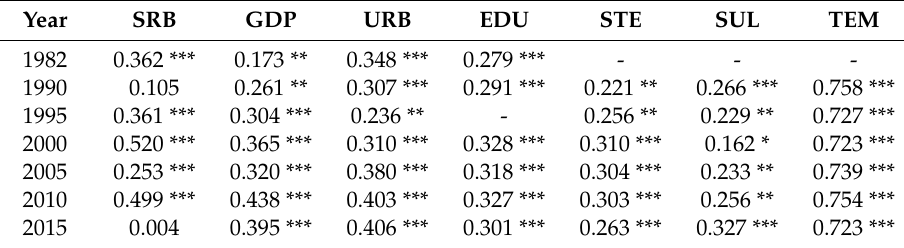
Table 2. Global Moran’s Index of SRB and Explanatory variables since